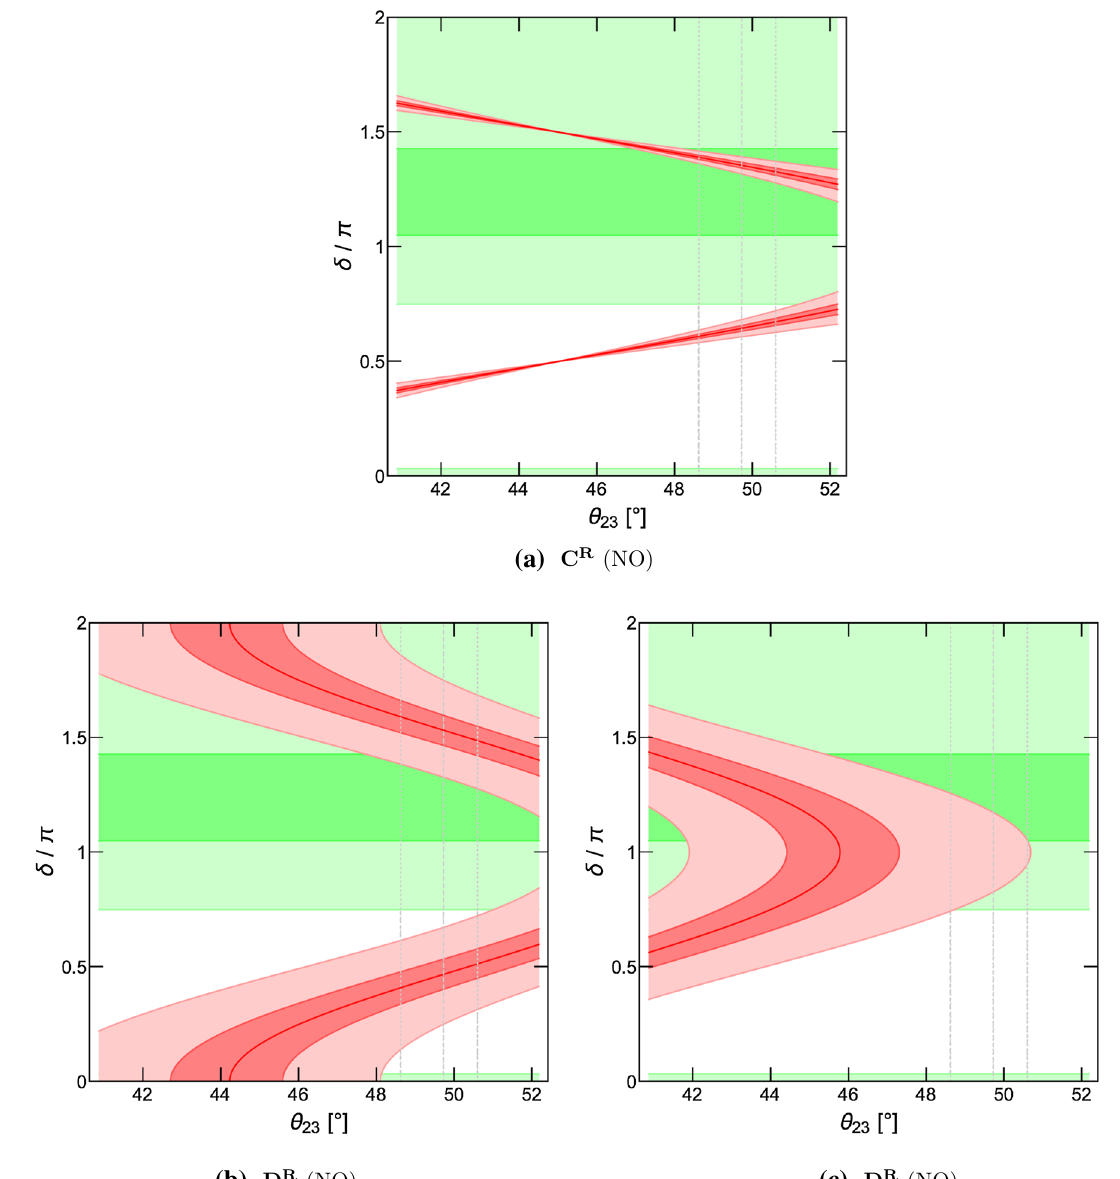
Fig. 4 The predictions for the Dirac CP phase in the singlet models. The red line shows the prediction as functions of θ 23 and the dark (light) red bands show the uncertainty coming from the 1 σ (3 σ ) errors of θ 12